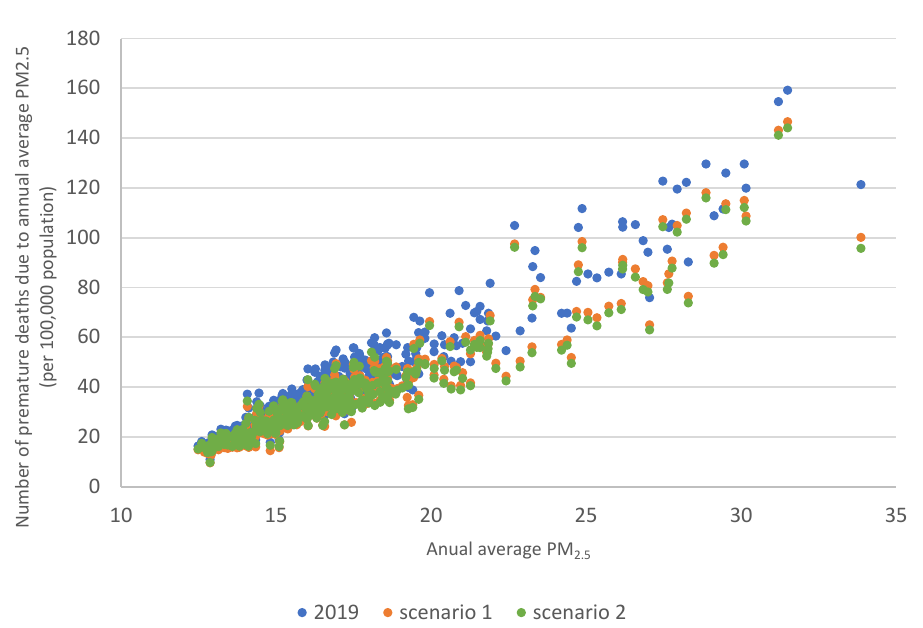
Figure 10. Number of premature deaths per 100 000 inhabitants due to high PM2.5 concentrations in counties in Poland in 2019 (blue points) and scenario 1 (orange points) and scenario 2 (green points).